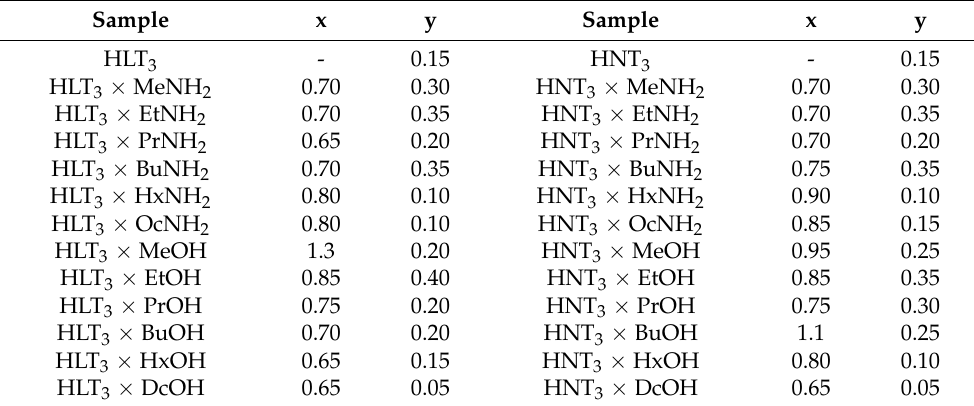
Table 2. Quantitative composition of the initial titanates and their inorganic-organic